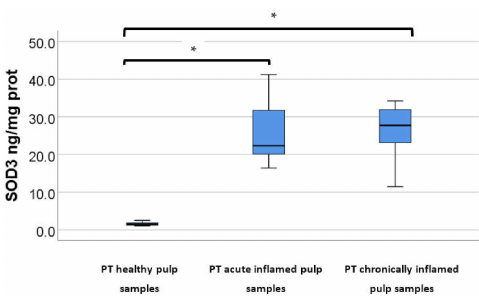
Figure 2. SOD-3 protein levels (ng/mg) in the control group versus acute/chronic pulpitis. (* Indicates statistically significant